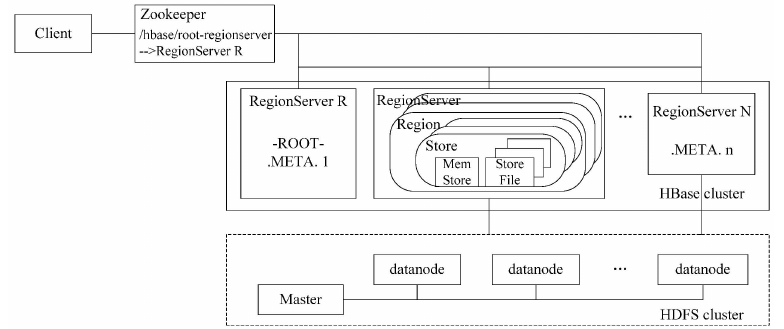
Figure 1. The relationship between Hadoop and HBase.